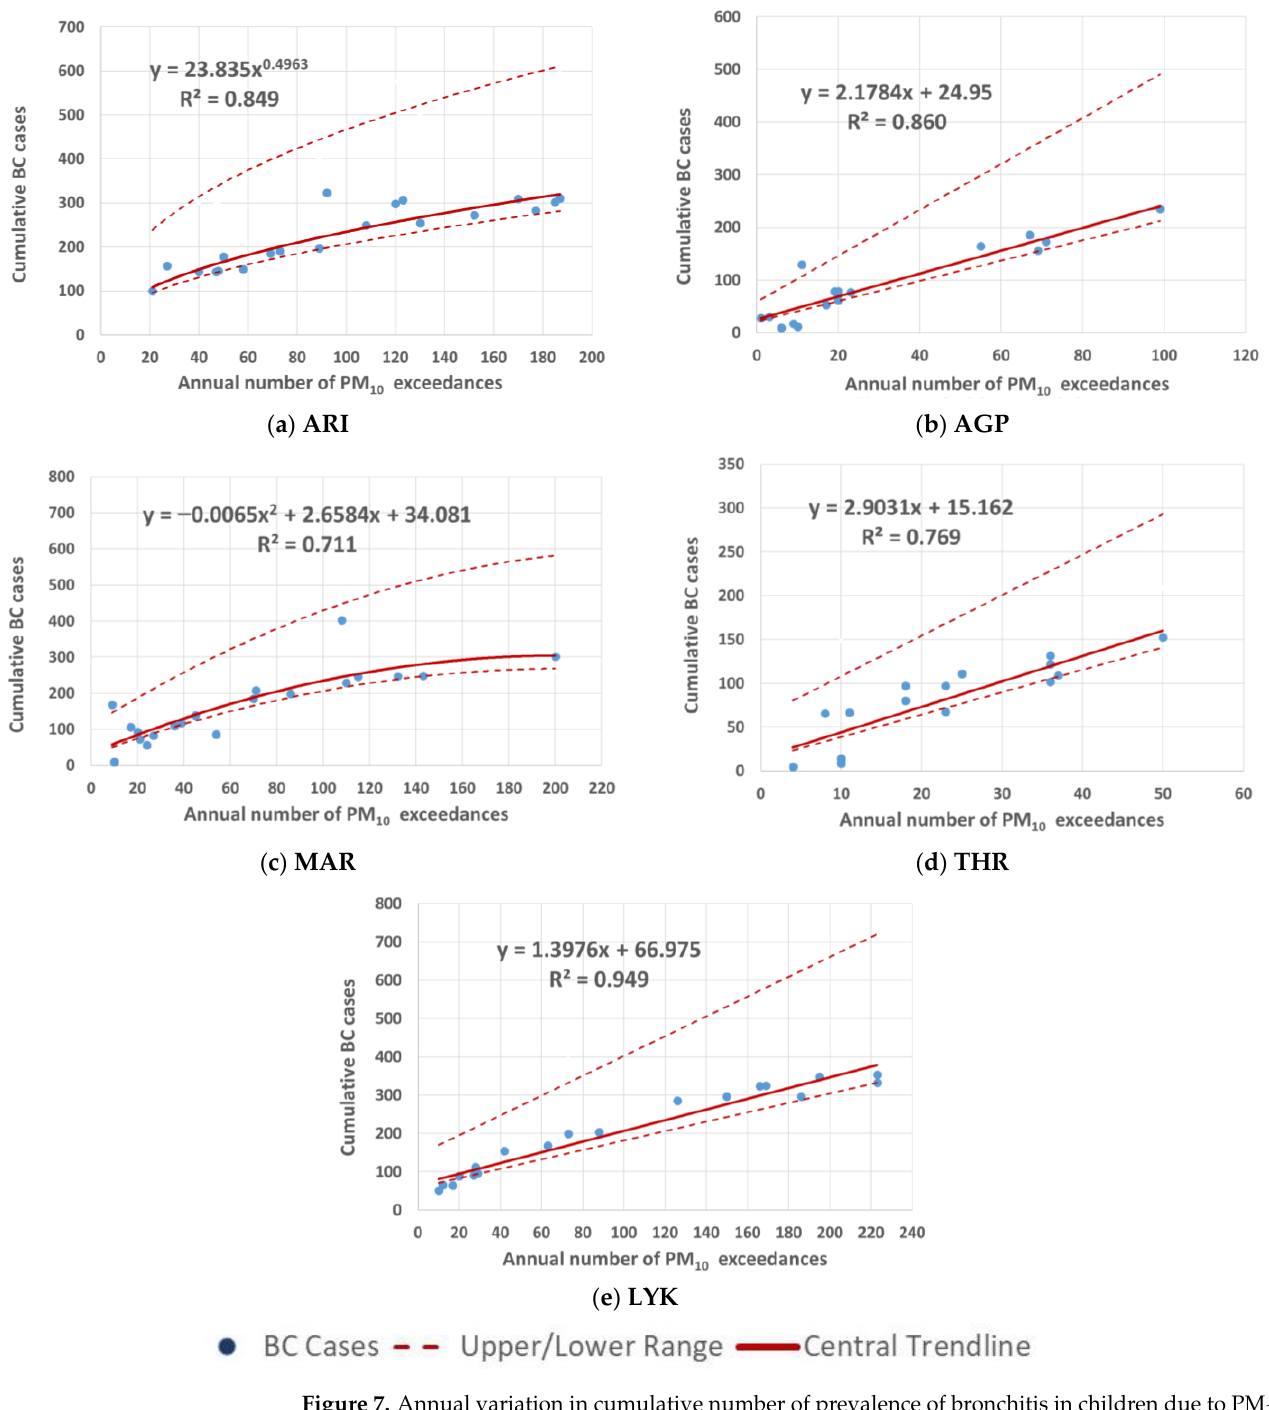
Figure 7. Annual variation in cumulative number of prevalence of bronchitis in children due to PM 10 exposure vs. annual number of PM 10 exceedances of all examined stations within the GAA. Period 2001 – 2020. (( a ): ARI, ( b ): AGP, ( c ): MAR, ( d ): THR, ( e ): LYK).